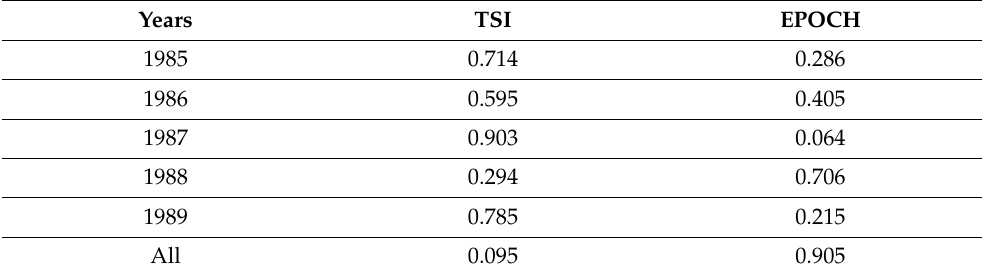
Table 2. Important parameters for every year, as well as in